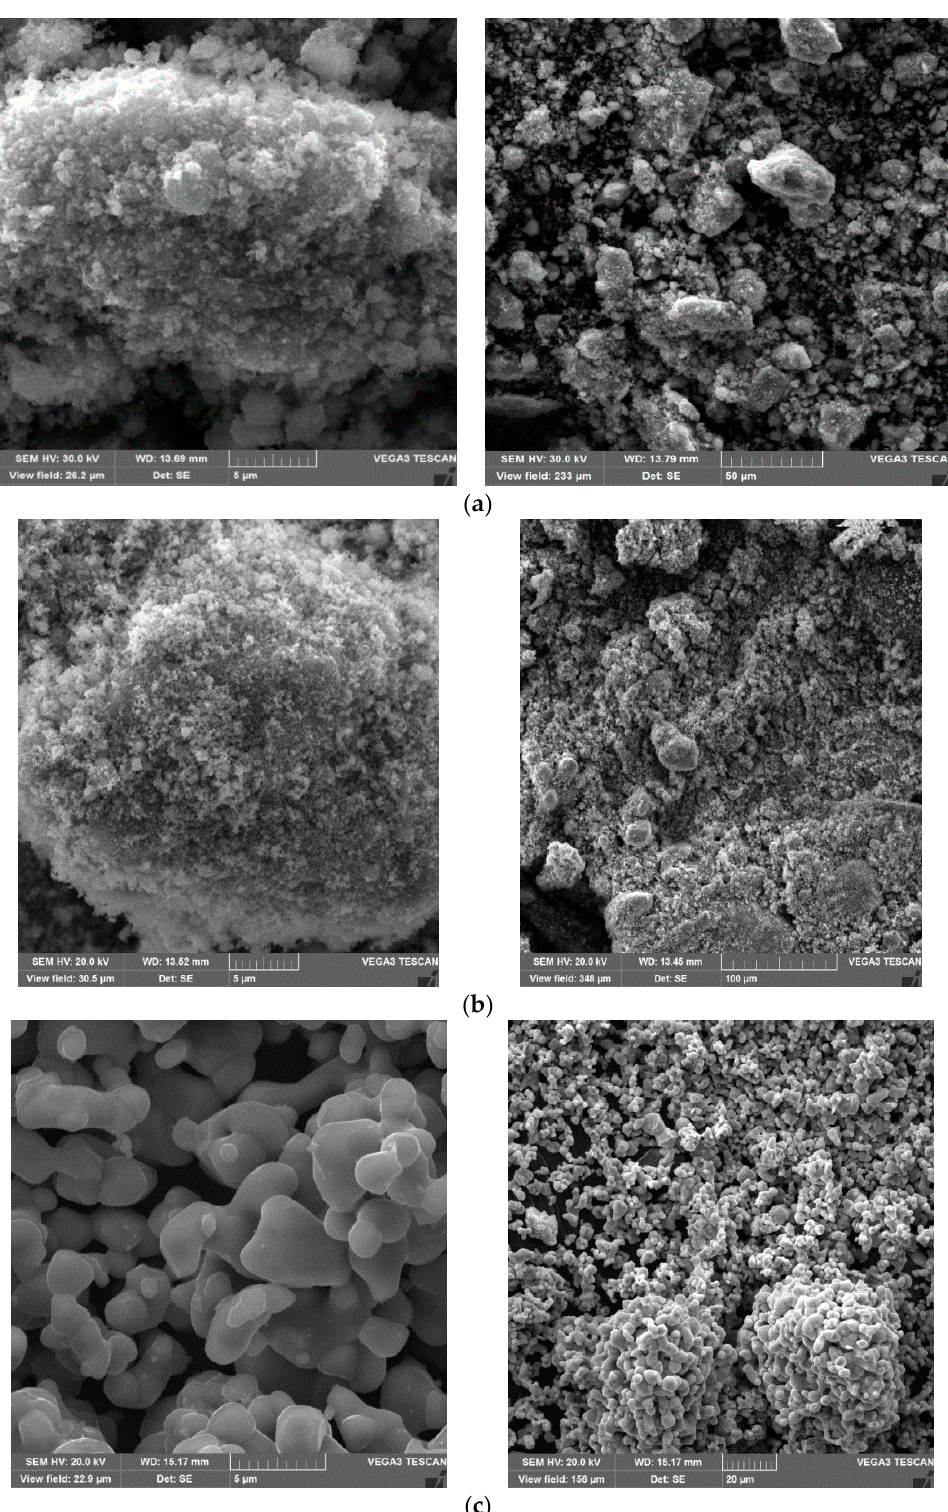
Figure 6. SEM images of cobalt ferrites obtained at the temperatures, ◦ C (mechanochemical synthesis ( a , b ), solid phase synthesis ( с )): ( a )—350, ( b )—450, ( с )—1100.